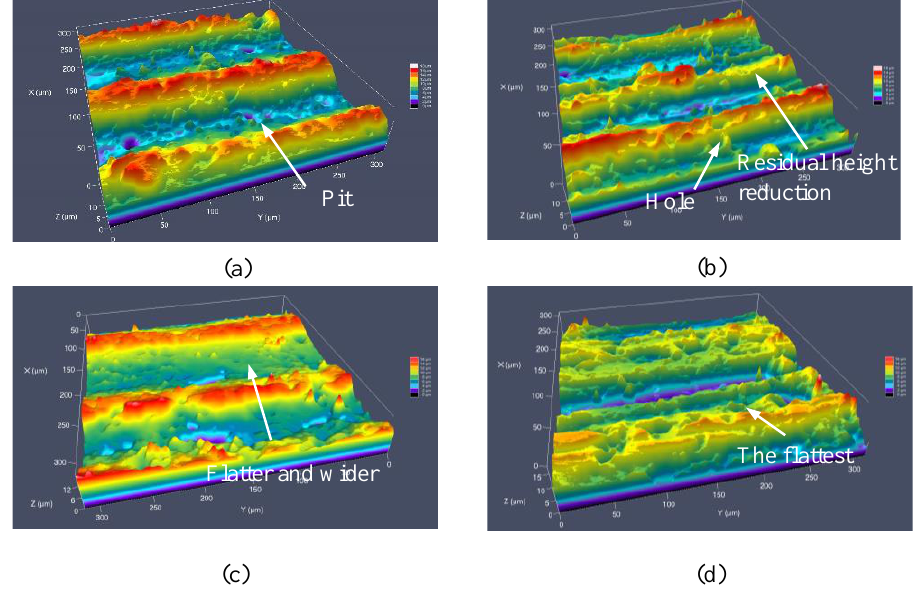
Figure 8. The surface topography of different processes: ( a ) GM; ( b ) G-E-D-M; ( c ) 2UGM; and ( d ) 2UG-E-DM.